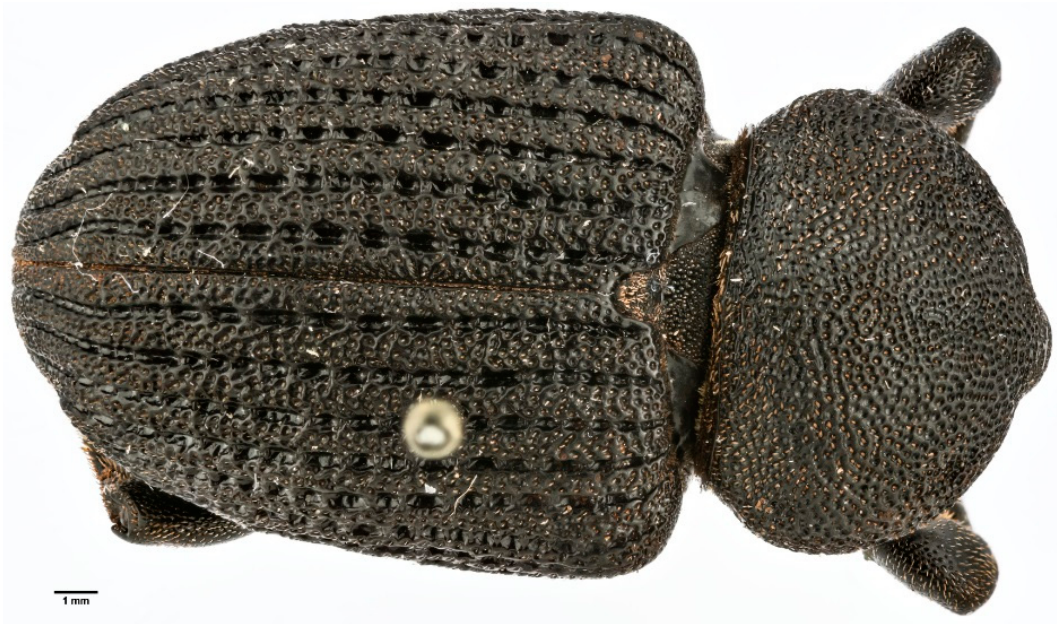
Figure 11. Sclerocardius bohemani Schoenherr: holotype of Charactocnemus hintzi Hartmann, dorsal. Photograph by Marc Srour.